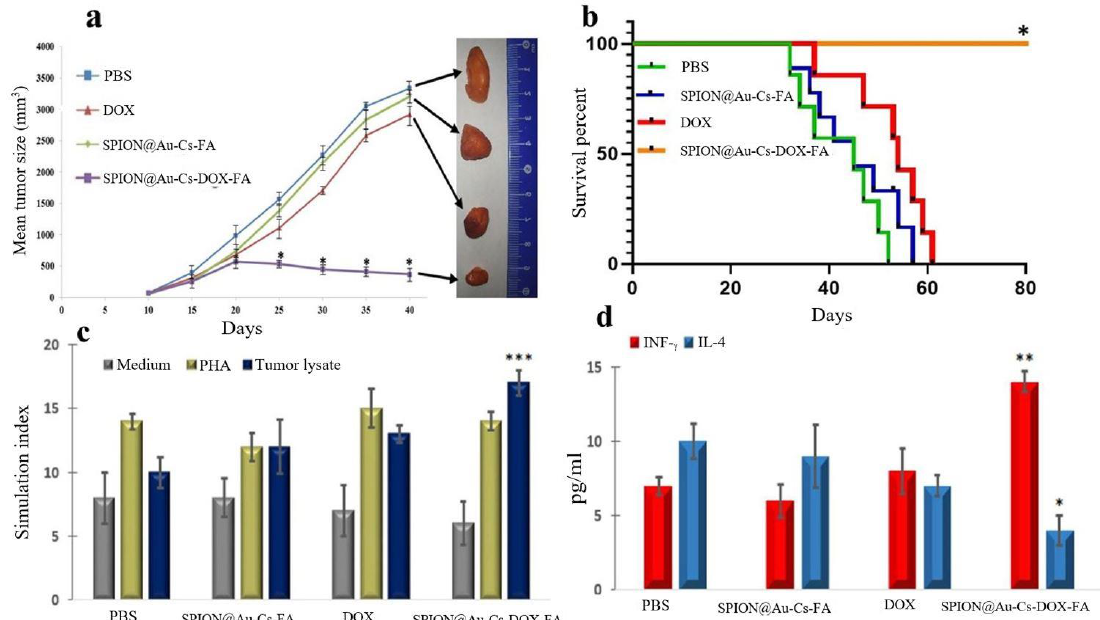
Figure 7. The in vivo antitumor effects of SPION@Au-CS-DOX-FA in a mice tumor model. Changes in the tumor size in representational mice (four groups). ( a , b ) on day 19 the tumor growth in mice treated with SPION@Au-CS-DOX-FA was reduced significantly ( p < 0.01) relative to that of the other groups received free DOX, SPION@Au-CS-FA NPs, and PBS. ( c ) the proliferation index of splenocytes following the induction of tumor lysate, PHA (positive control), and medium (negative control). ( d ) splenocytes collected from mice treated by SPION@Au-CS-DOX-FA were re-stimulated with tumor lysate. A substantial increase ( p < 0.05) in IFN-ÿ levels compared with those of other groups and a significant decrease ( p < 0.05) in IL-4 production was observed in the mice receiving SPION@Au-CS-DOX-FA nanoformulation compared with those given DOX, SPION@Au-CS-FA, and PBS. Results indicate the mean of measurements carried out in triplicate (mean ± S.D., (* p < 0.05; ** p < 0.01; *** p < 0.001); n = 3).